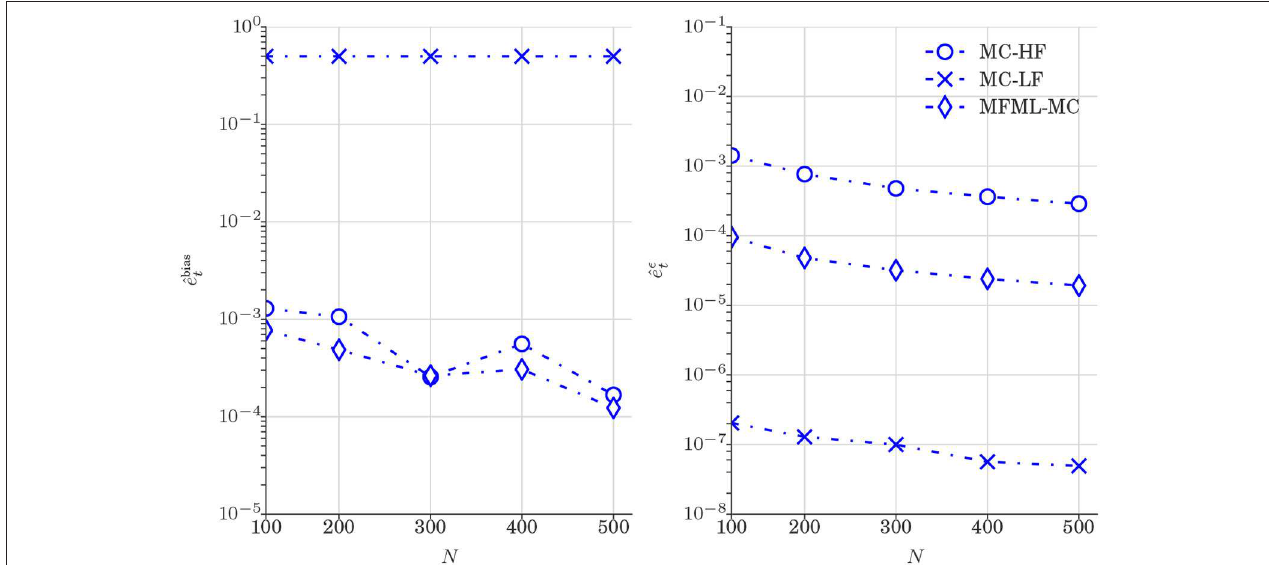
e bias t and e ǫ t (Equation 24) for the estimation of E [ u t ] (water saturation field at 6 ˆ ˆ